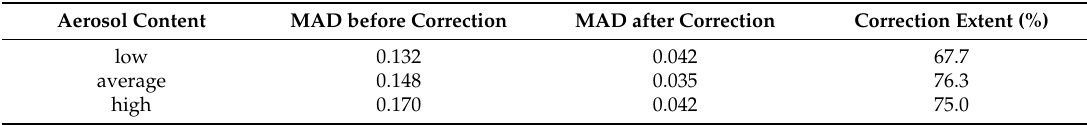
Table 5. Correction extent (%) under different aerosol loading